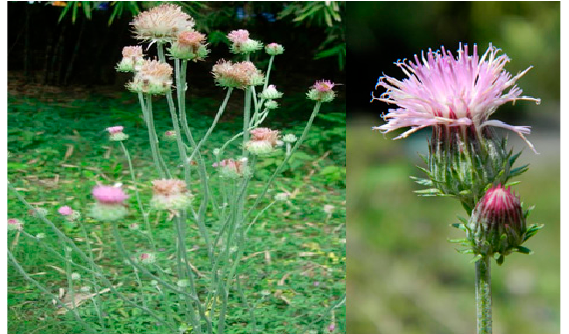
Figure 1. Saussurea heteromalla L.